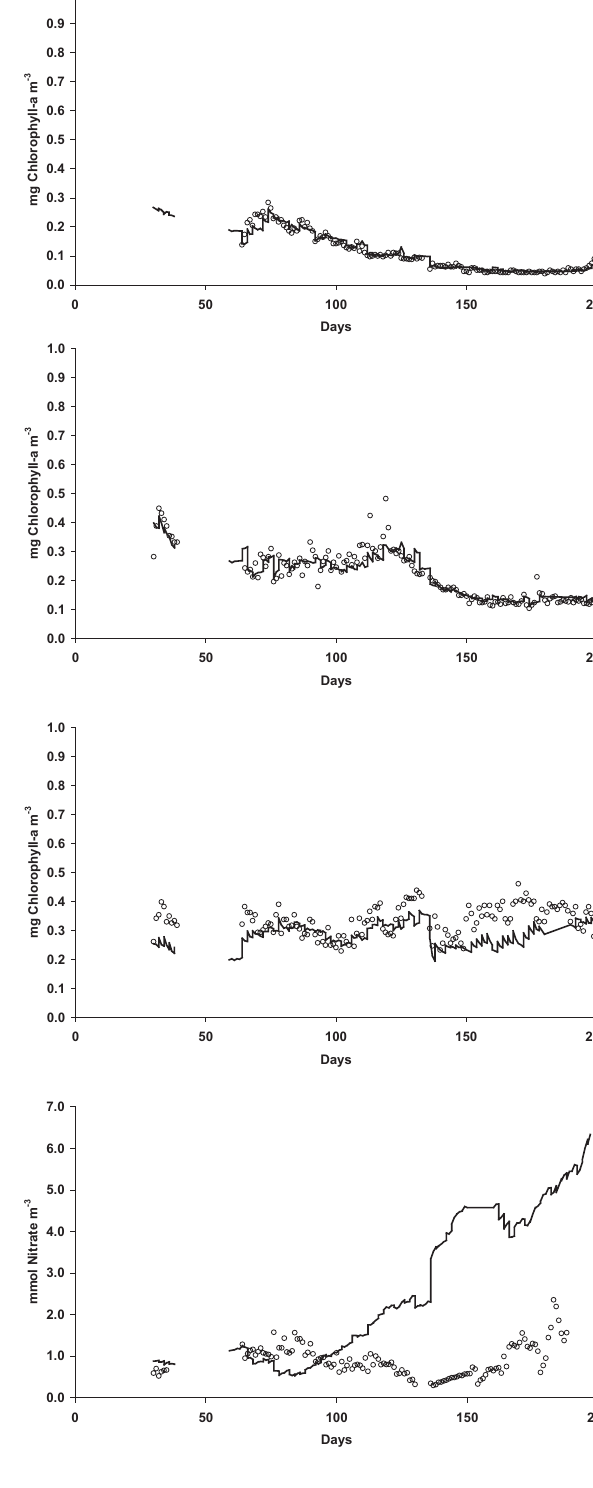
Fig. 5. Reference solution ( ) for chlorophyll-a at (a) 40m, (b) 65m and (c) 115m and nitrate at 45m at the M3A site, along with data ( ◦ ) and the climatology ( ).